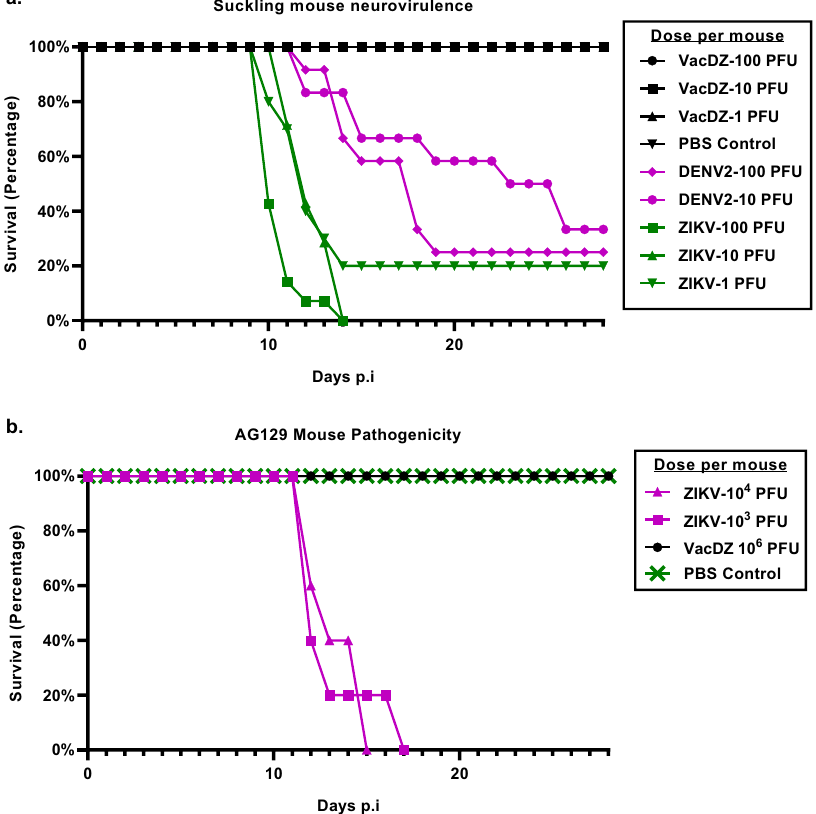
Fig. 3 Survival curve for neurovirulence and pathogenicity studies in mice. a Neurovirulence studies in suckling mice. Newborn outbred white ICR mice were challenged with different doses of VacDZ, DENV2-16681, or ZIKV via intracranial inoculation. The mice were kept for four weeks and observed daily for clinical symptoms and killed when they reached a humane endpoint. Group sizes: PBS control, n = 6; VacDZ, n = 11 for all titres; DENV2, n = 12 for all titres; ZIKV-100 PFU, n = 14; ZIKV-10 PFU, n = 7; ZIKV-1 PFU, n = 10. b Pathogenicity studies in adult AG129 mice. 5-8 weeks old AG129 mice were challenged with the indicated doses of VacDZ or ZIKV or PBS control via intraperitoneal inoculation. Doses indicated are per mouse. Group sizes were n = 5 for ZIKV challenge, and n = 6 for VacDZ or PBS challenge. The mice were kept for four weeks and observed daily for clinical symptoms and killed when they reached a humane